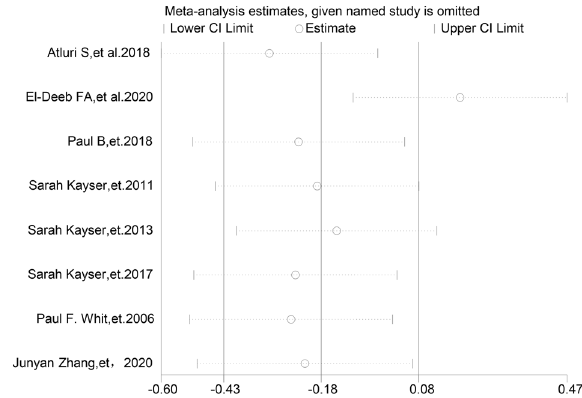
Fig. 3 Relative effects of each separate dataset on the pooled effect size for MST and ECT effects on